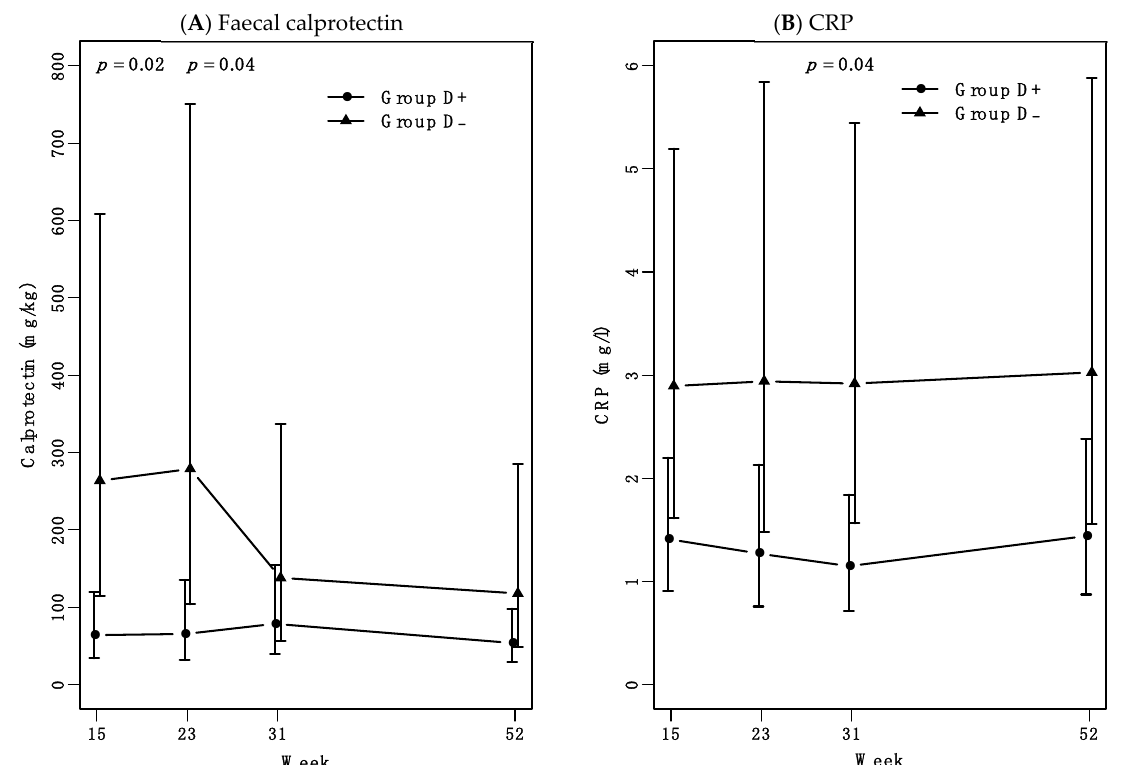
Figure 2. Faecal calprotectin and CRP levels from weeks 15 to 52. During follow-up all patients were treated with infliximab. Data are presented as estimated medians with 95% confidence interval (CI). ( A ) Faecal calprotectin levels in Group D- were 3.8 times higher at both week 15 and week 23 compared to group D+. At weeks 31 and 52, calprotectin levels were not significantly different between the two groups. The overall median curves of the two groups tended to be non-parallel (mixed model, p = 0.1). ( B ) Median curves for CRP levels over time were close to parallel, but shifted. Group D- had a 2.2 times higher median curve compared with group D+ ( p = 0.04).